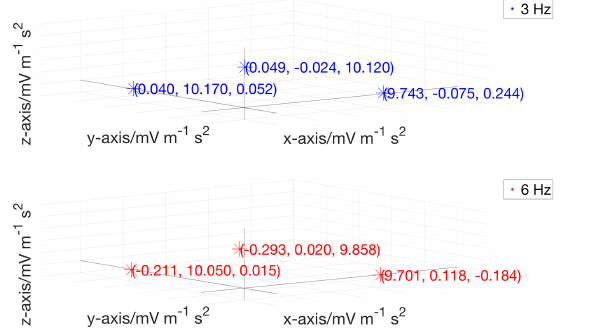
Figure 9. Piezo-electric accelerometer: sensitivity matrix obtained by means of Method 3 (3-D diagram).